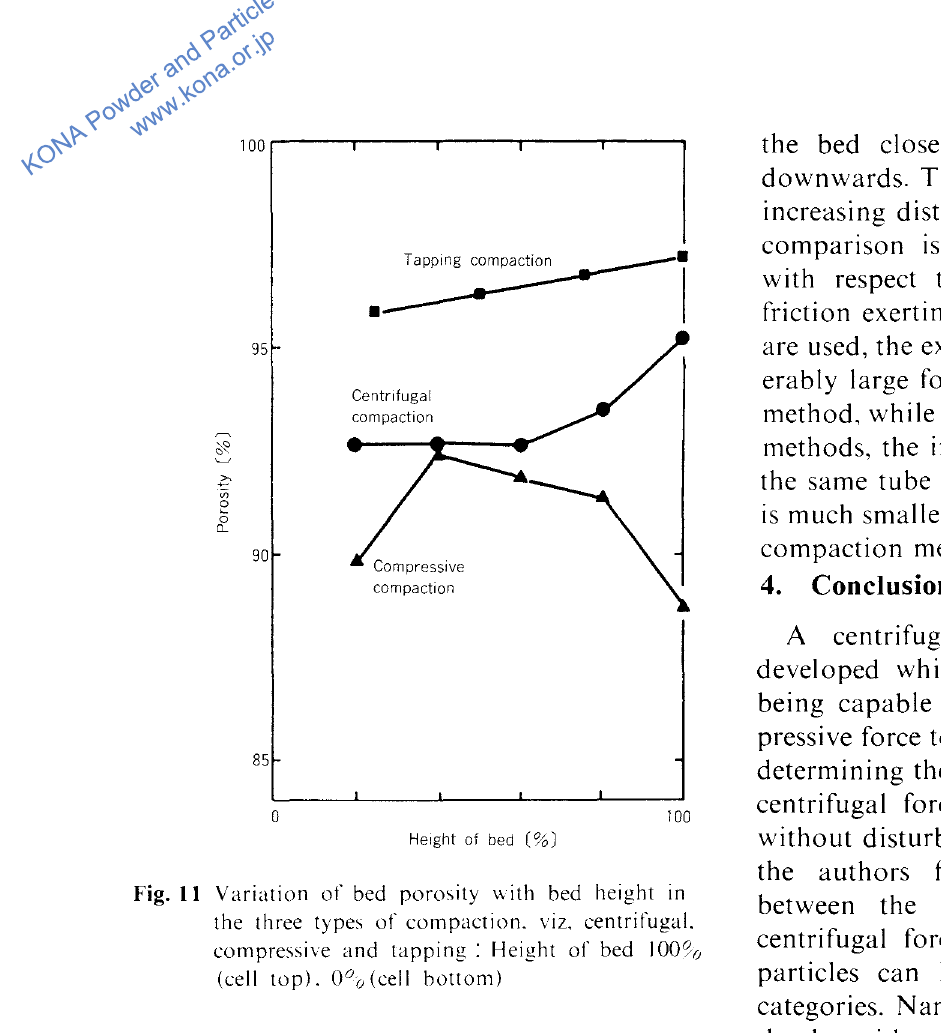
Fig. II Variation of bed porosity with bed height in the three types of compaction. viz. centrifugal. compressive and tapping : Height of bed JOO'?o (cell top). 0°o(cell